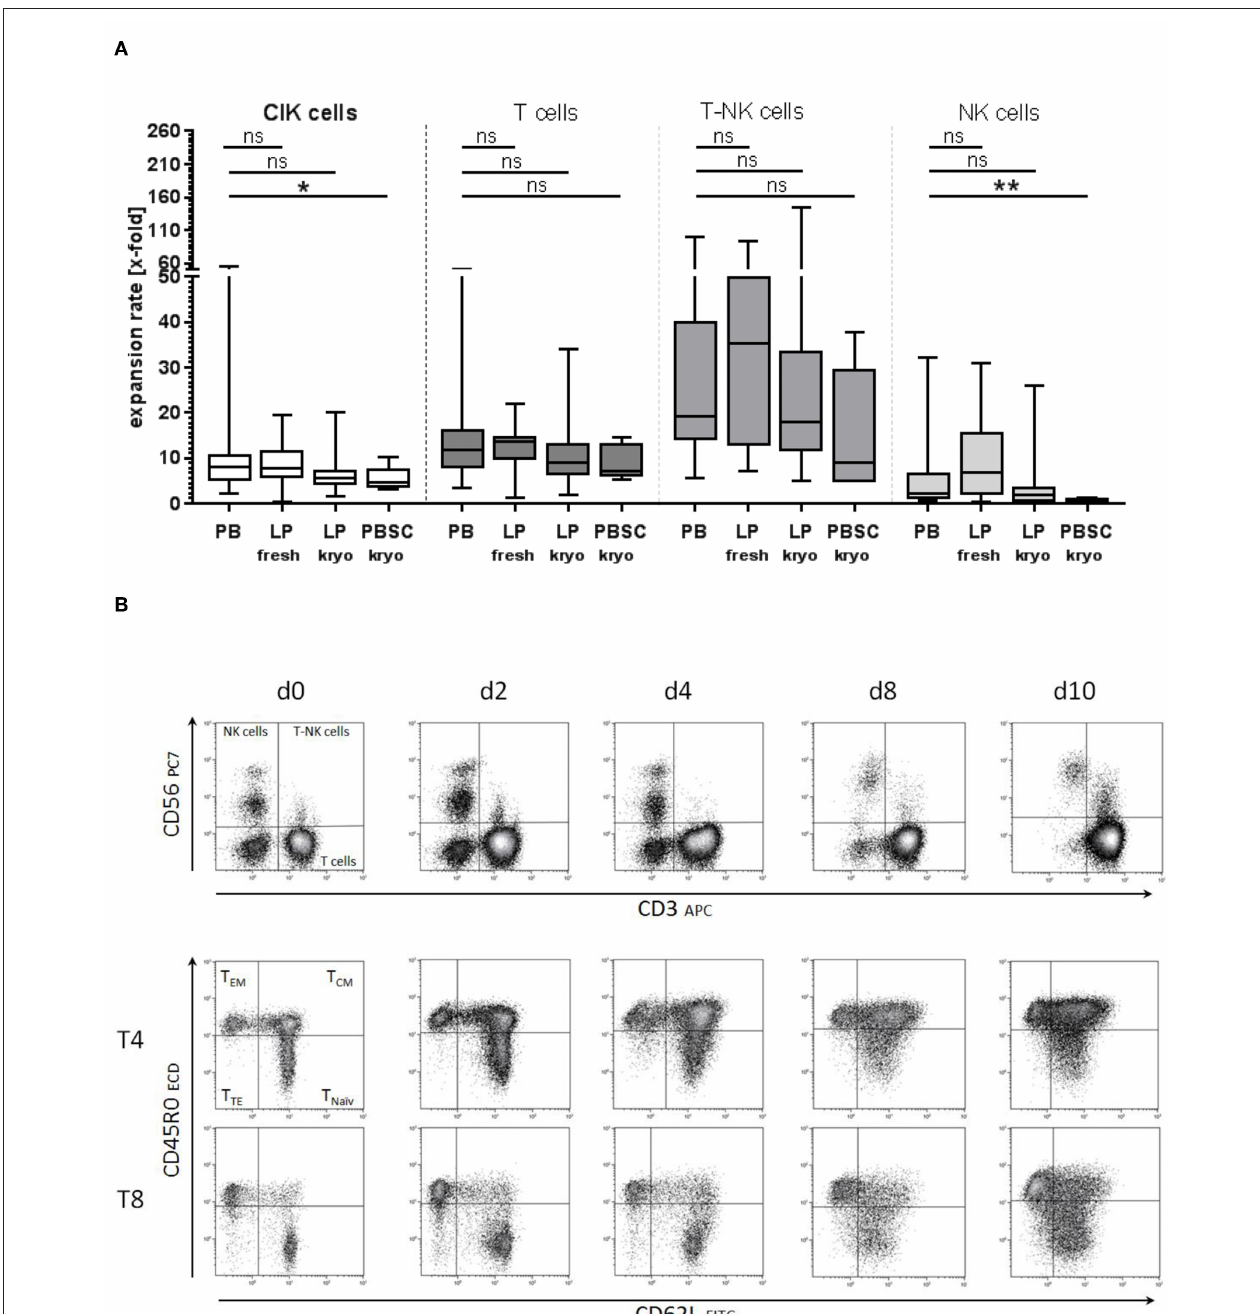
FIGURE 4 | Starting material of CIK cell generation. (A) CIK cell generation on the basis of different starting materials showed comparable expansion rates for peripheral blood (PB) and unstimulated leukapheresis products (LP, fresh, and cryopreserved). Significantly lower proliferation was observed when CIK cells were generated from cryopreserved G-CSF stimulated PBSC ( n = 5). (B) No significant differences in the composition of naïve and memory T cells were detected between CIK cells generated from the different starting materials. Exemplarily shown for PB are the subgroups of naïve, central- and effector-memory T cells for cytotoxic and helper T cells on days 0, 2, 4, 8, and 10 generated from PB. T, T cells, EM- effector memory; CM, central memory; TE, terminally differentiated. *p < 0.05, **p < 0.01.